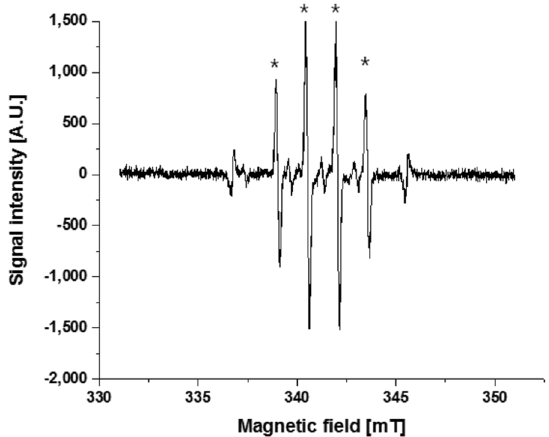
Figure 1. ESR measurement after exposure of the culture medium to 50 Gy of X-rays. The asterisked four peaks are the DMPO-OH signals and the outer two peaks are the Mn markers.